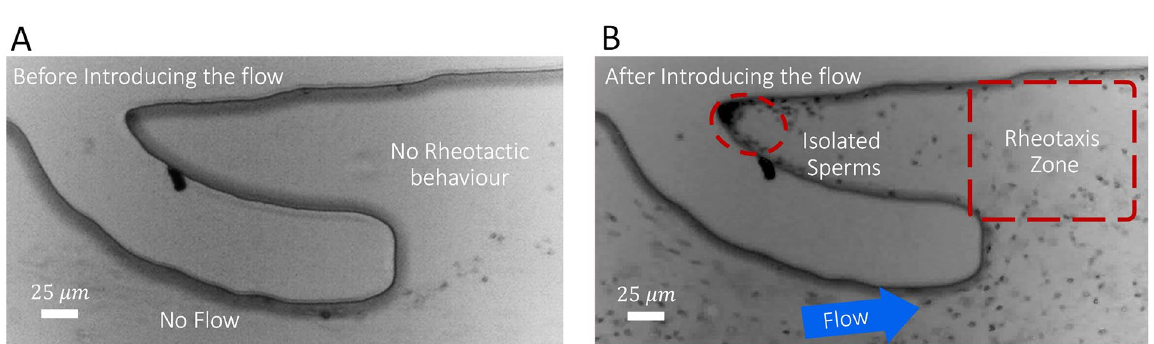
Figure 3. Rheotaxis-based isolation of sperm into micropockets. ( A ) In the absence of flow, sperm depart from the micropocket wall to follow the main microchannel’s wall towards the device outlet. ( B ) At a flow rate of 2 µL/min, motile sperm exhibited rheotaxis behaviour to enter the micropockets. The red dashed box indicates the shear protected zone in the frontal section of the